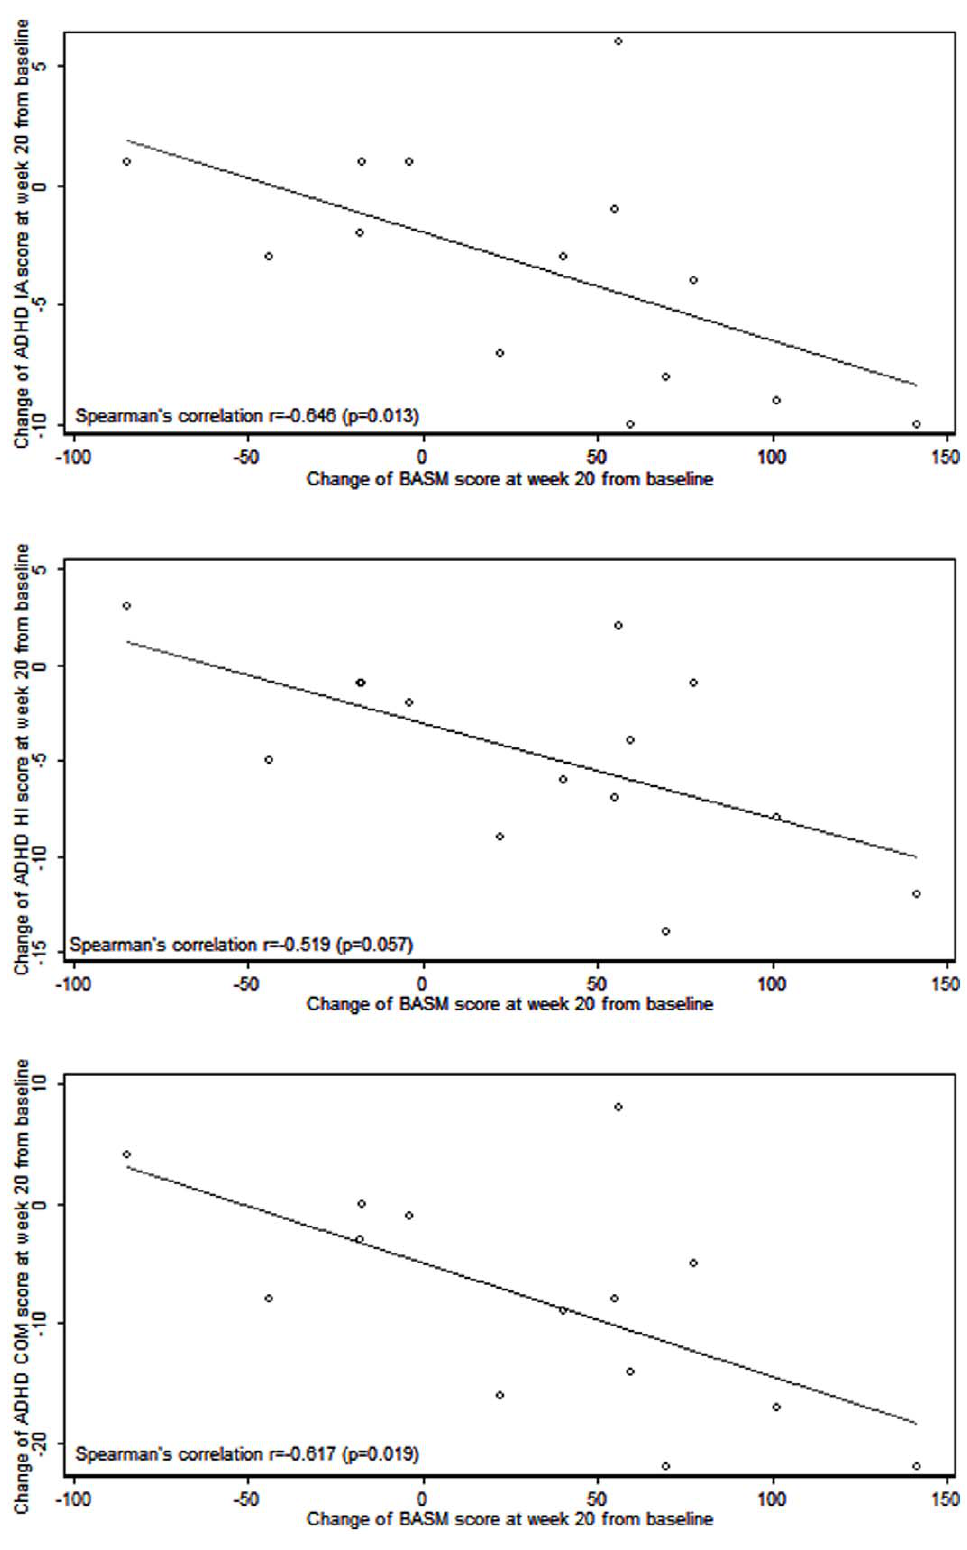
Figure 4. Correlations between change in BCI and BCI ADHD Severity Measure (BASM) scores from Week 0 to 20. doi:10.1371/journal.pone.0046692.g004 change was not statistically significant (mean change = 32.5 (60.8), p = 0.067).